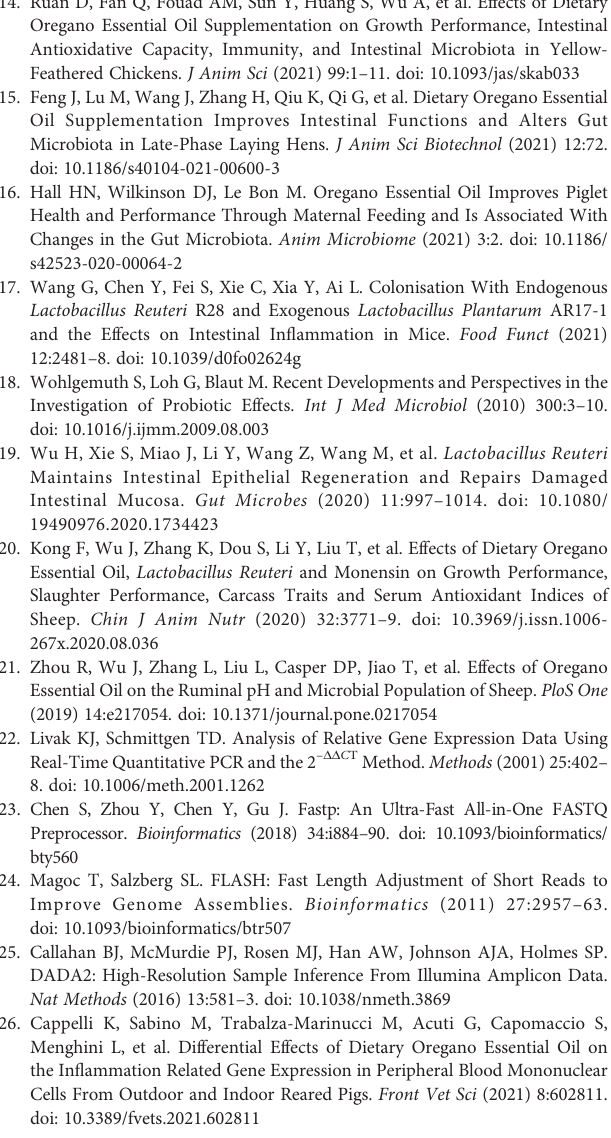
Supplementary Table 1 | Composition and nutrient levels of the basal diet. Supplementary Table 2 | Primers sequences used for real-time PCR. Supplementary Table 3 | Candidate ileal metabolites that differed between the CON and trial groups. Supplementary Figure 1 | (A – C) Alpha diversity as presented by ACE, Shannon, Simpson index in the ileal contents of sheep among groups. (D – F) Extended error bar